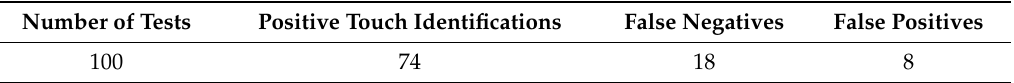
Table 1. Touch identification test results.